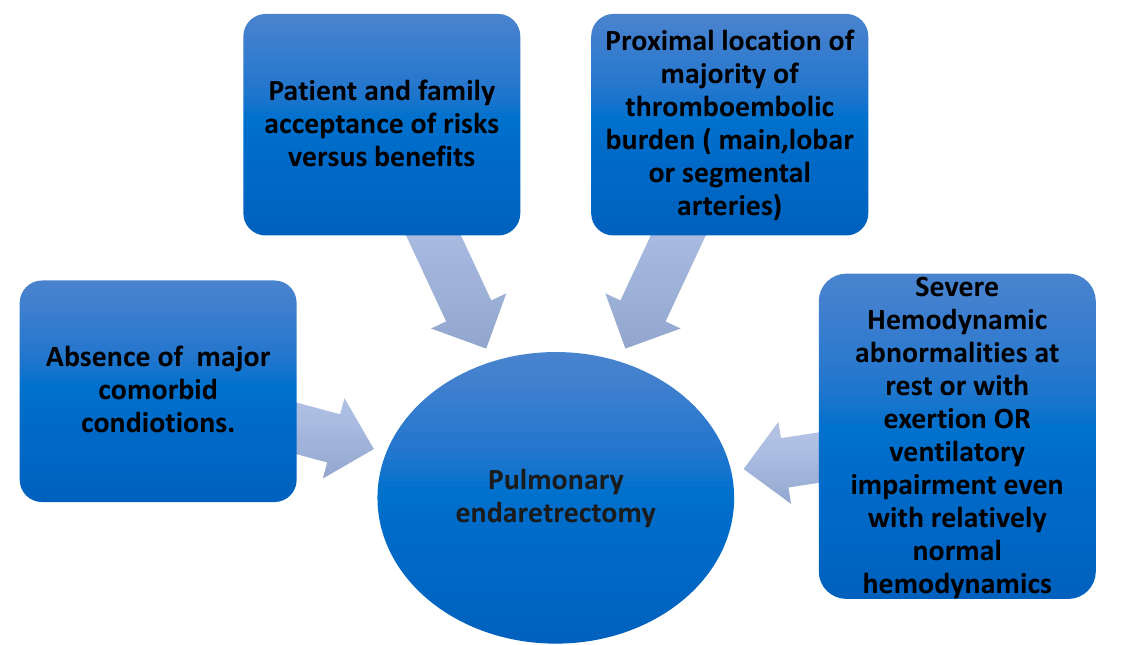
Figure 3. Major factors associated with the decision to proceed with pulmonary endarterectomy. As per the international registry of CTEPH, the 3-year survival of patients undergoing PEA is 90% as compared to 70% in those without surgery [38]. In another study where a larger cohort was followed for 10 years, survival was 72% [25,39] (Figure 4).